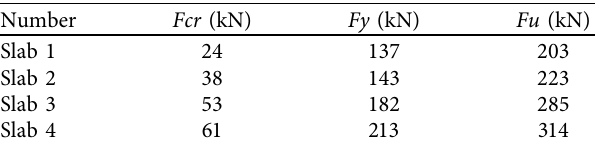
Figure 10: Load-deflection curves at the bottom of Slab 1–Slab 4 in the plate across. Table 5: Characteristic value of bearing capacity of the test